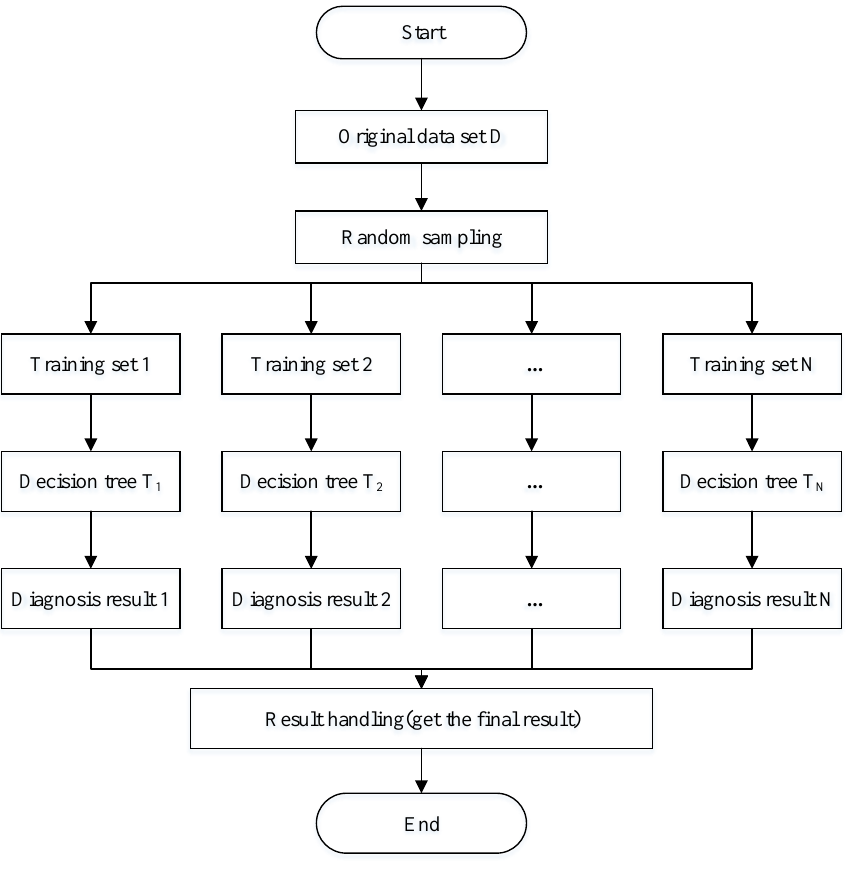
Figure 7. Random Forest Classification